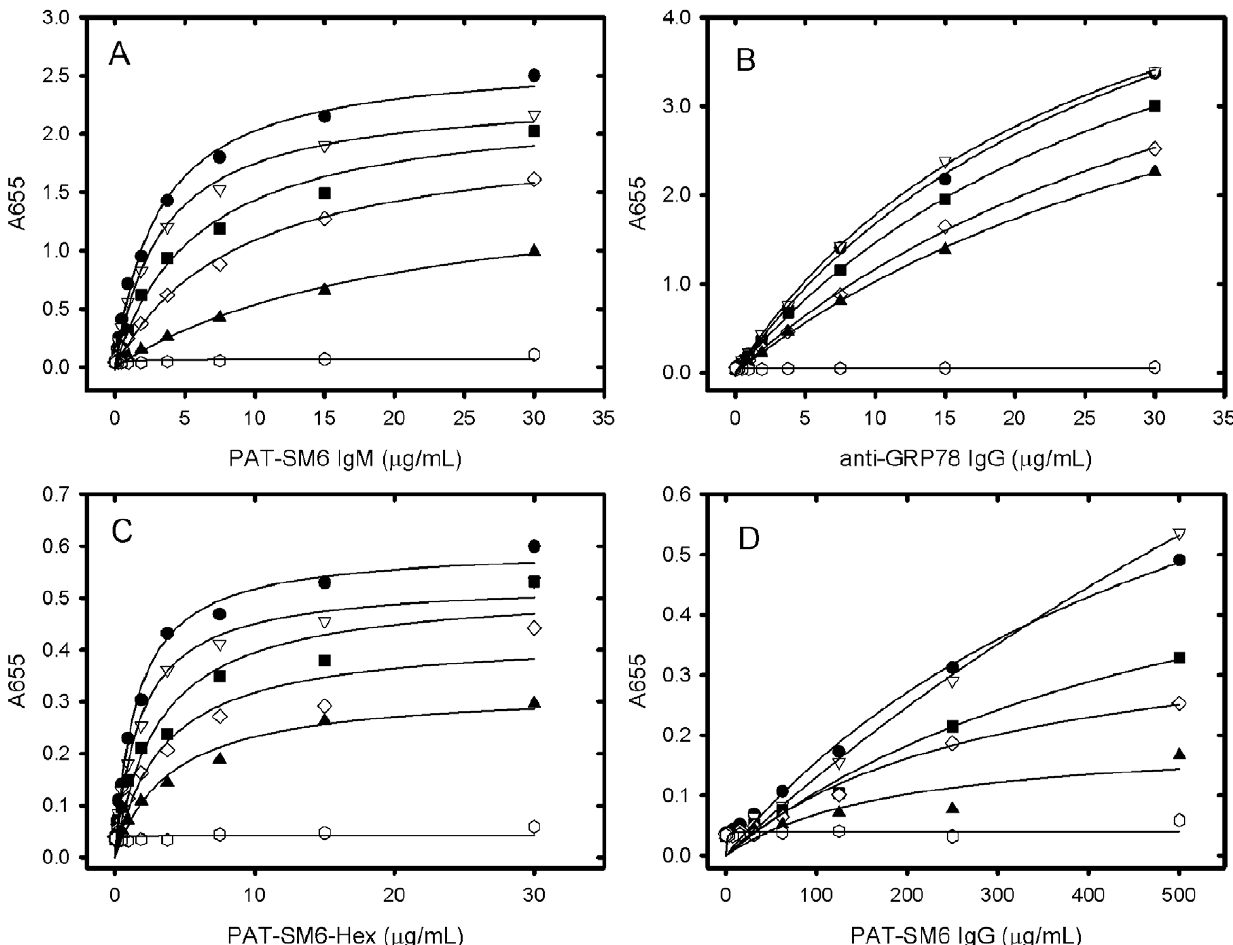
Figure 7. Effect of GRP78 coating concentration on the binding of PAT-SM6 to immobilised GRP78. The primary antibodies used were: A. PAT-SM6; B. polyclonal anti-GRP78; C. PAT-SM6-hex and D. PAT-SM6 IgG. The GRP78 coating concentrations were 30 m g/mL (closed circles), 15 m g/ mL (open inverted triangles), 7.5 m g/mL (closed squares), 3.75 m g/mL (open diamonds), 1.88 m g/mL (closed triangles), 0 m g/mL (open circles). The solid lines are best-fit lines calculated for a simple binding